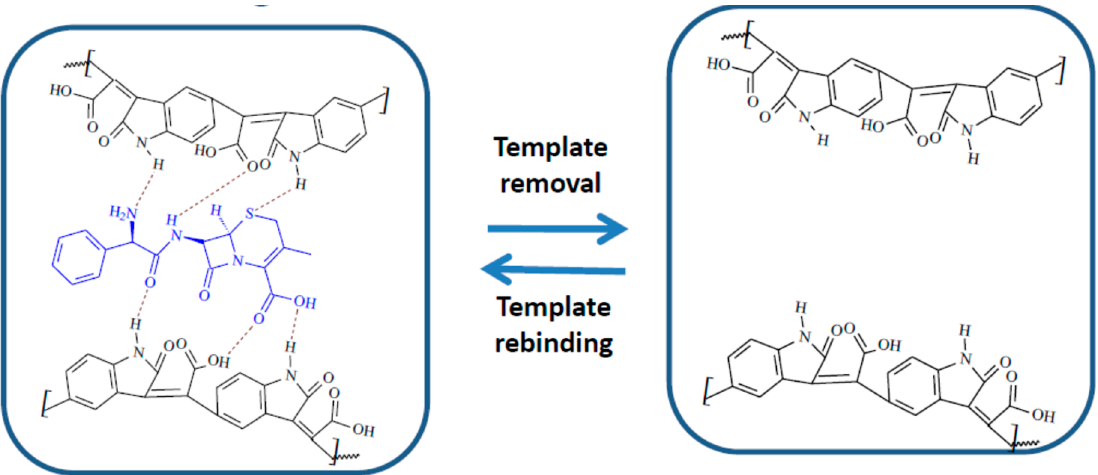
Figure 2. Interaction mechanism between the MIP film and CFX.